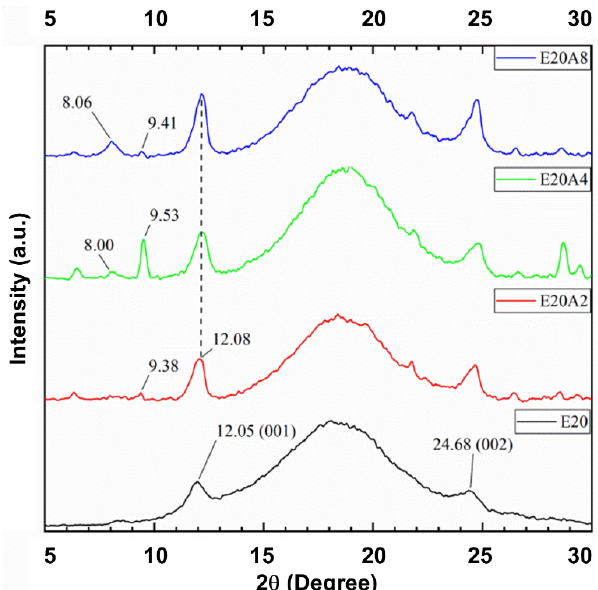
Figure 6. XRD scattering patterns of ENR/HNT composites filled with untreated and acid-treated HNT (un-deformed